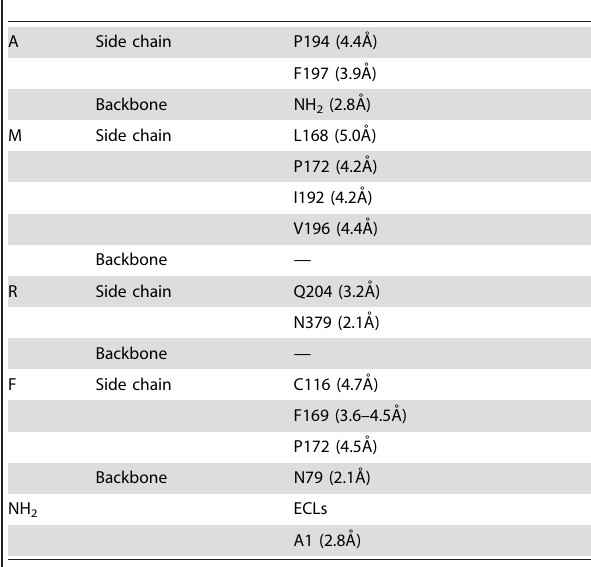
Table 6. AMRF-NH 2 ligand-receptor contact sites, pose B a .